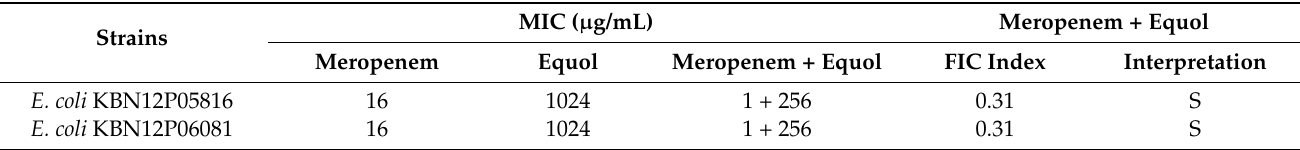
Table 3. Combinatory effects of equol and meropenem against carbapenem-resistant E. coli .